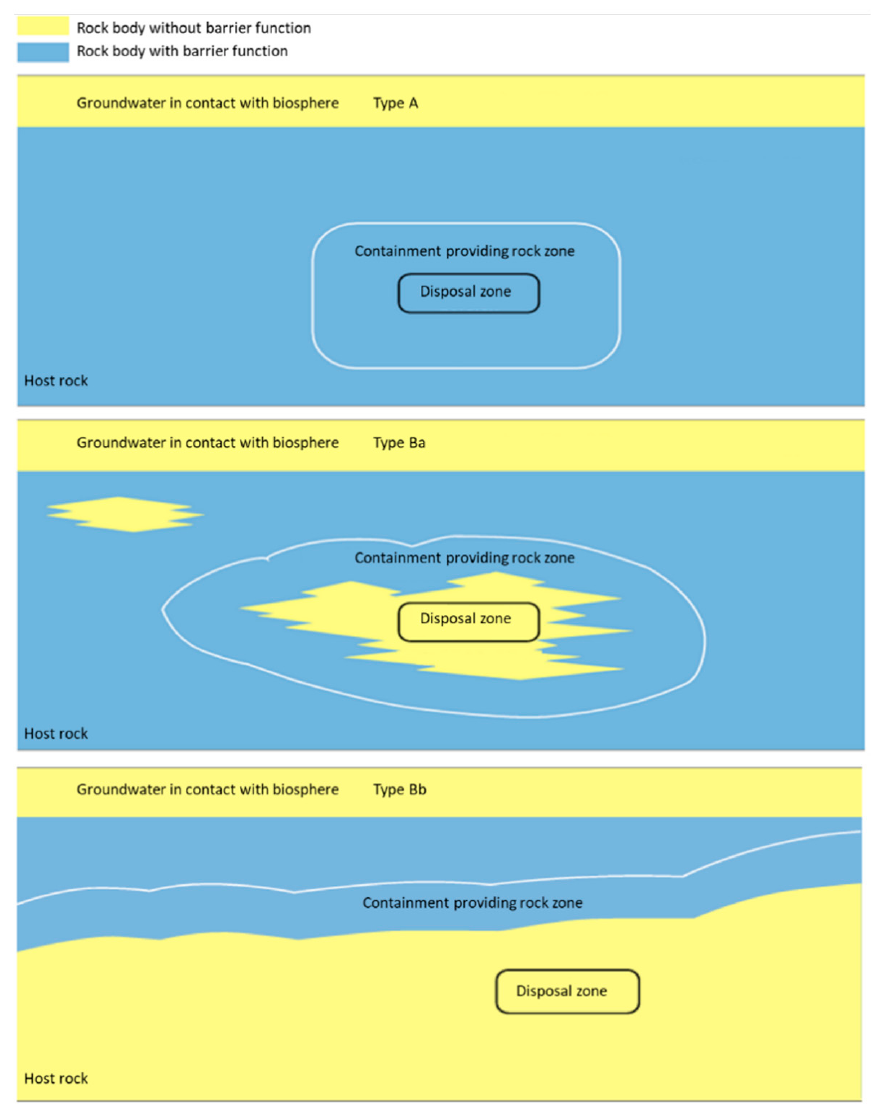
Figure 3. Types of containment providing rock zones (not to scale).